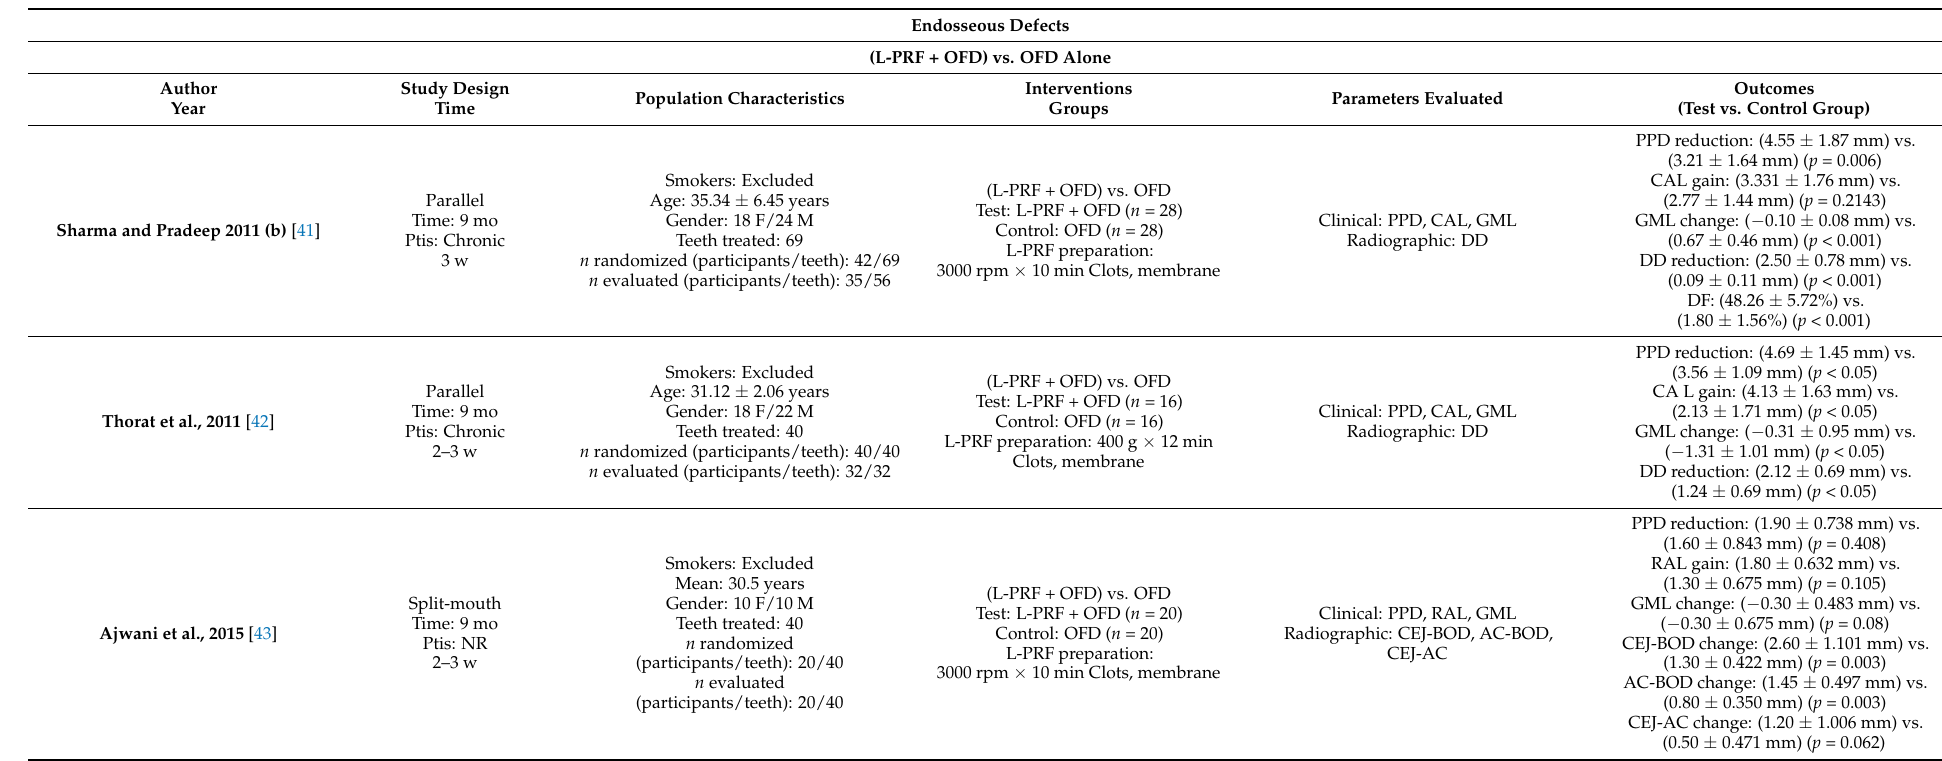
Table 2. Characteristics of included